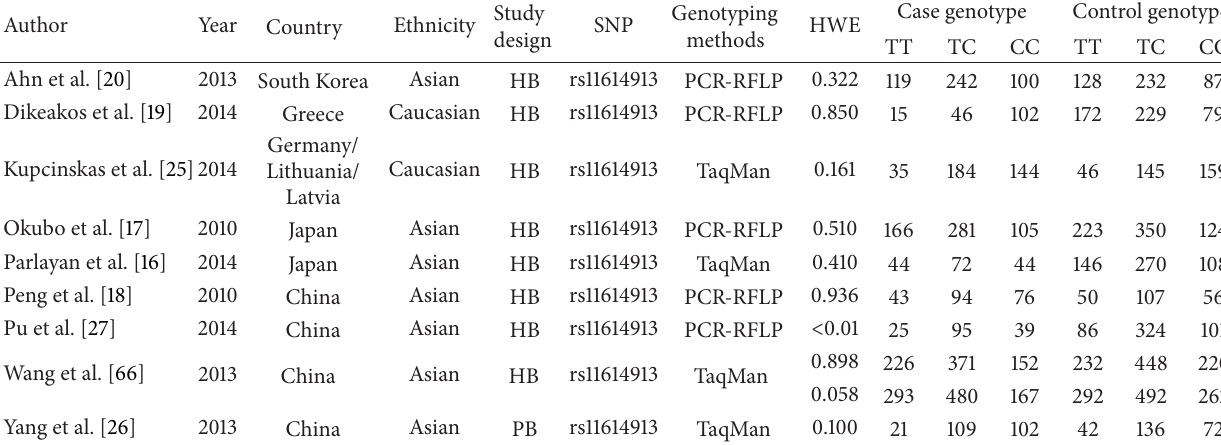
Table 2: Characteristics of included studies on rs11614913.